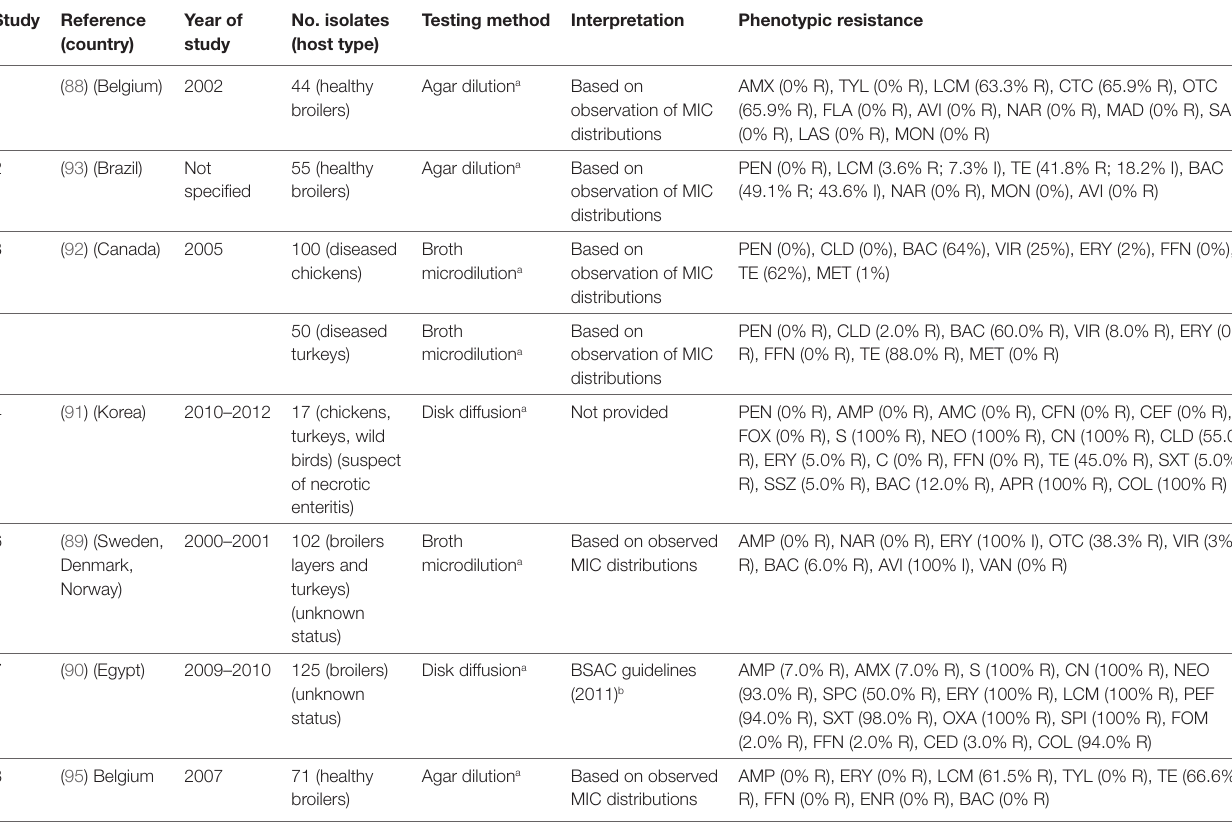
TABLe 7 | Summary of results of 8 phenotypic studies on antimicrobial resistance of C. perfringens from poultry. Study Reference